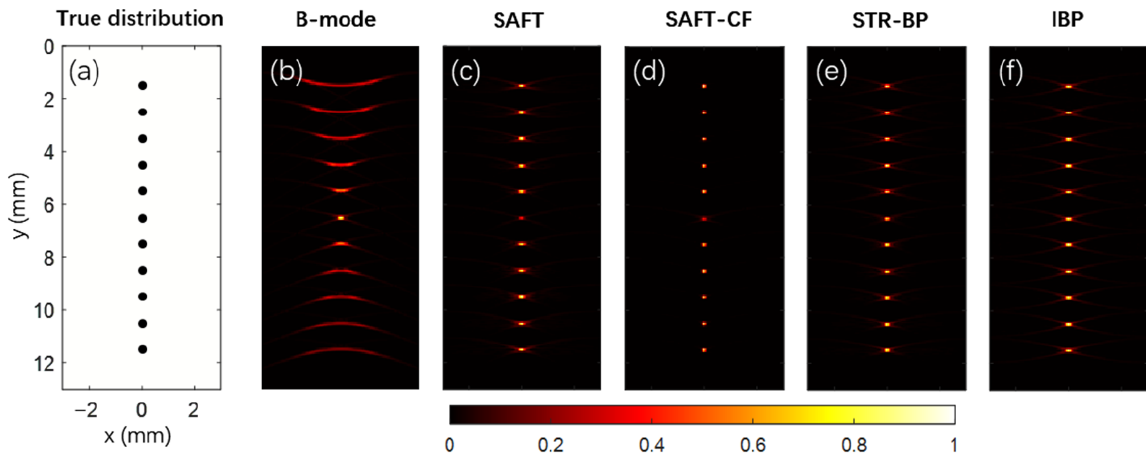
Figure 3. Comparison of point targets at different depths reconstructed with different methods. ( a ) The actual distribution of the point target and ( b – f ) the results given by the B-mode, SAFT, SAFT- CF, STR-BP, and IBP methods, respectively. Here the x-axial is the lateral direction, and the y-axial is the depth direction.